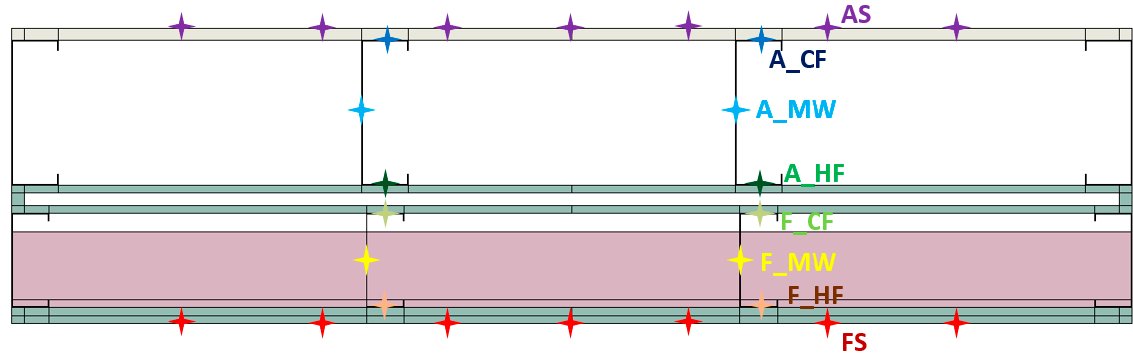
Figure 10. Through thickness temperature monitoring locations.